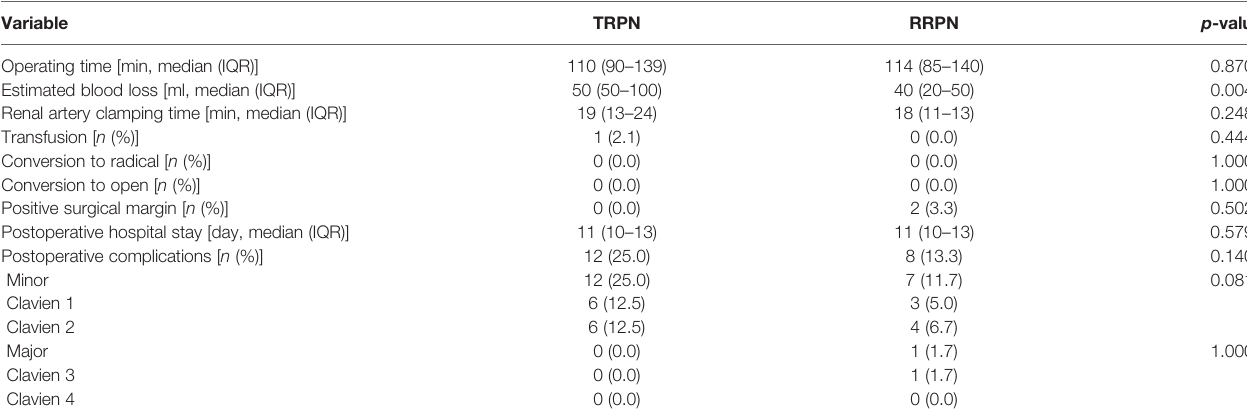
TABLE 2 | Perioperative